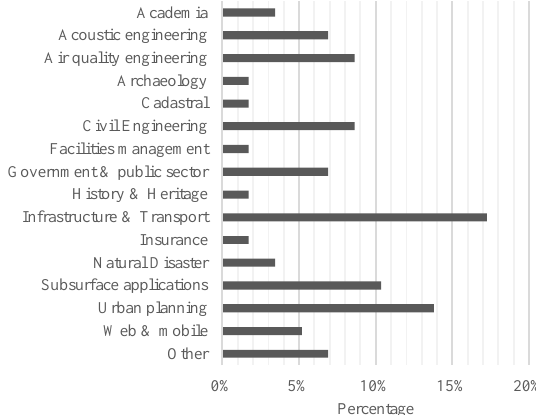
Figure 1. Which sector do you work in? ( n